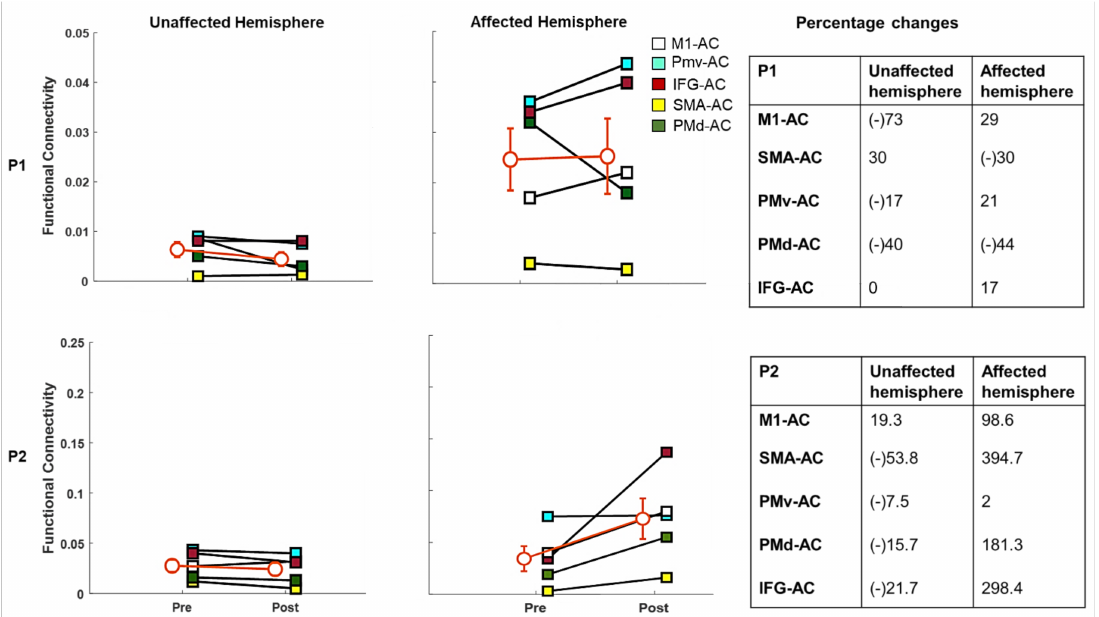
Figure 4. Intracortical coherence in the β -band in Participant 1 and Participant 2 with percentage connectivity changes before and after MST. The error bars (i.e., orange line) represent the standard error of the mean in the overall connectivity. (M1: primary motor cortex, AC: auditory cortex, SMA: supplementary motor area: PMv: premotor ventral area, PMd: premotor dorsal area, IFG: inferior frontal gyrus, P1: Participant 1, P2: Participant